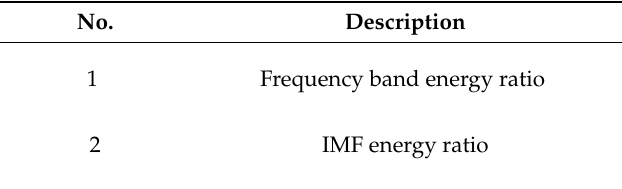
Table 4. Statistical features in the TFD.